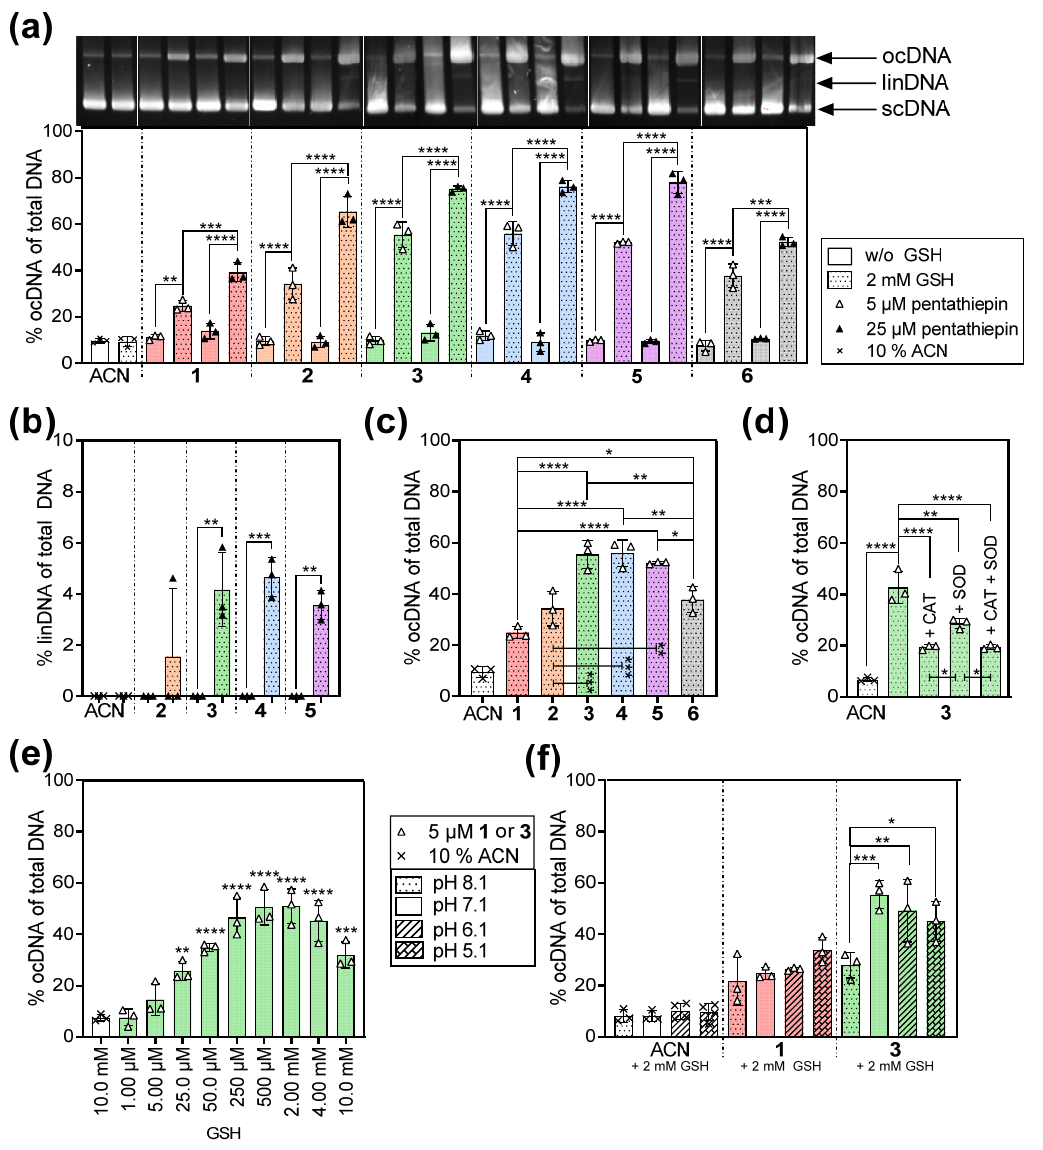
Figure 11. Cleavage of the plasmid DNA after treatment with pentathiepins for 20 h at 37 ◦ C under different conditions. ( a ) Percentage of open circle (oc) DNA after incubation of pBR322 with 5 or 25 µ M of pentathiepins 1–6 with or without 2 mM glutathione at pH 7.1. ( b ) Percentage of linearized (lin) DNA after incubation of pBR322 with 25 µ M of pentathiepins 2–5 with 2 mM of GSH at pH 7.1. ( c ) Percentage of ocDNA displayed as inter-compound comparison. ( d ) Percentage of ocDNA after incubation of pBR322 with 5 µ M of pentathiepin 3 and 2 mM of GSH in the absence and presence of 100 µ g/mL of CAT or SOD or both at pH 7.1. ( e ) Percentage of ocDNA after incubation of pBR322 with 5 µ M of pentathiepin 3 with GSH concentrations from 1.00 µ M to 10.0 mM at pH 7.1, with asterisks indicating significant differences from solvent control with 10 mM of GSH. ( f ) Percentage of ocDNA after incubation of pBR322 with 5 µ M of pentathiepin 1 or 3 with 2.00 mM of GSH and different buffer pH ranging from 5.1 to 8.1. Background cleavage was assessed by incubation with the solvent acetonitrile (ACN). Quantification was performed with Image Lab and data are displayed as mean, with single values and SD. Original images are provided in the Supplementary Materials (Figures S39–S45). Statistical analysis was performed with Prism 7 by one-way ANOVA and Dunnett’s or Tukey’s multiple comparisons post hoc test. n = 3 independent experiments. * p < 0.05, ** p < 0.01, *** p < 0.001, **** p <